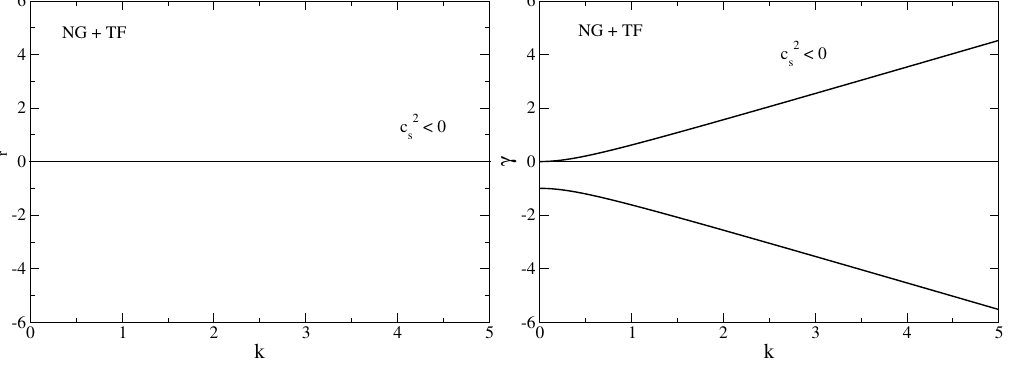
Figure 18. Dispersion relation for BECs in the nongravitational and TF limit ( G = ¯ h = 0) when c 2 s < 0. We have normalized the wavenumber by ξ / | c 2 s | 1/2 and the pulsation by ξ . This is equivalent to taking ξ = | c 2 s | = 1 in the dimensional